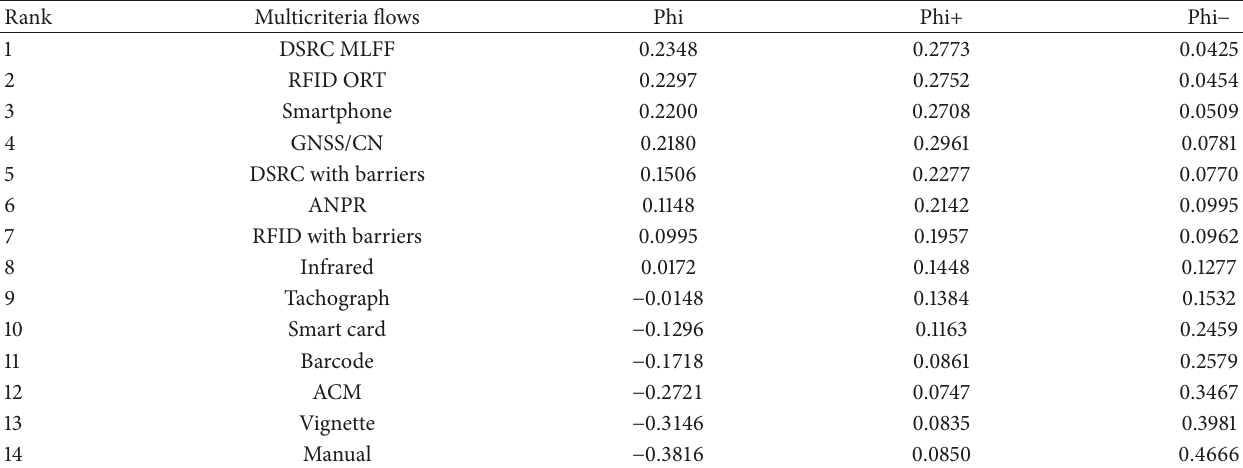
Table 10: Ranking of the toll alternatives using PROMETHEE